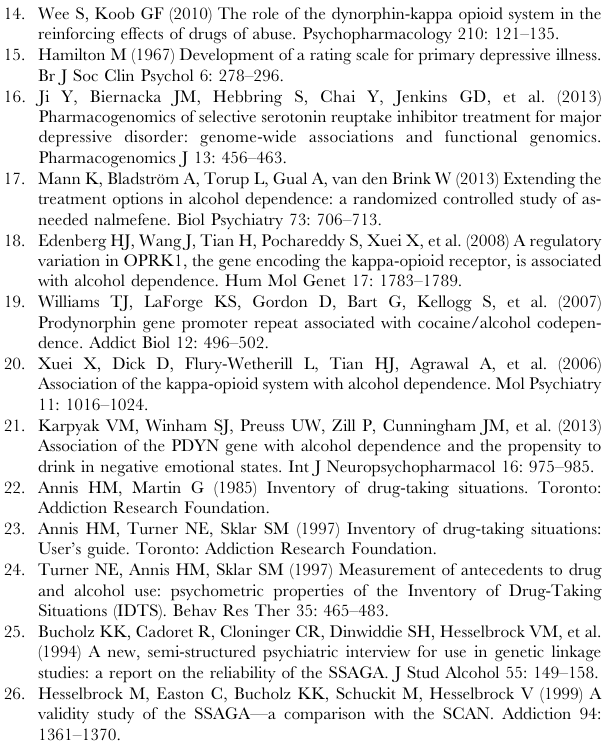
Table S1 Genotype and allele counts of rs2281285 by presence/ absence of the negative craving